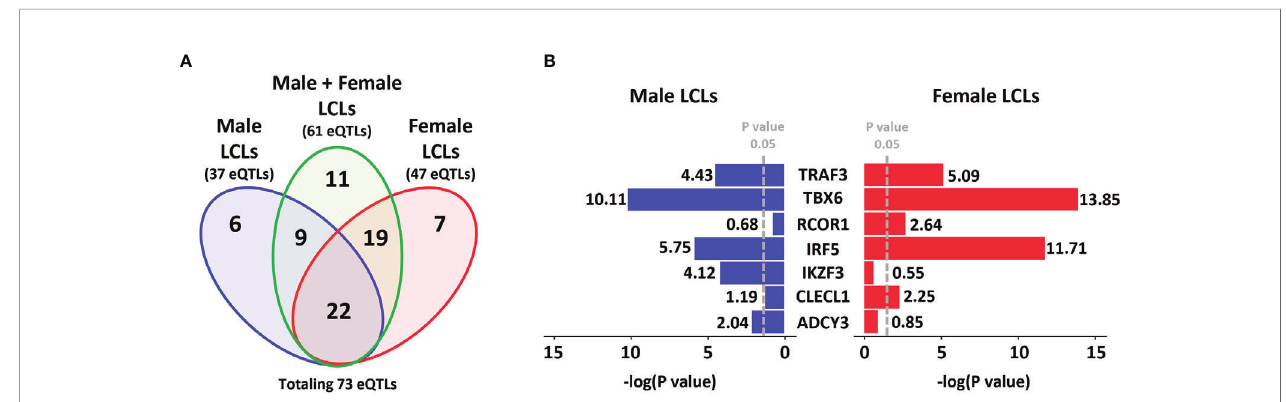
FIGURE 1 | MS risk SNP eQTLs pro fi le in LCLs demonstrates gender dimorphism. A total of 196 non-HLA MS risk SNPs were investigated to determine if they were eQTLs in LCLs (using a cut-off of p < 0.05) in the GEUVADIS dataset and those eQTLs identi fi ed were further investigated for gender dimorphism. (A) Data was divided into three sets, Male LCLs (blue), Male + Female LCLs (the entire cohort, green), and Female LCLs (red). A total of 37 eQTLs were detected in the Male set, 61 eQTLs were detected in the Male + Female set, and 47 eQTLs were identi fi ed in the Female set, with a total of 73 unique eQTLs occurring across the three sets. A total of 11 eQTLs were identi fi ed only in the Male + Female set. (B) Of the other 62 eQTLs, the 7 SNP:gene pairs with the strongest gender bias in eQTL effects in LCLs are presented. The GEUVADIS LCL cohort consisted of 358 European samples using RNA-seq including 187 female and 171 male